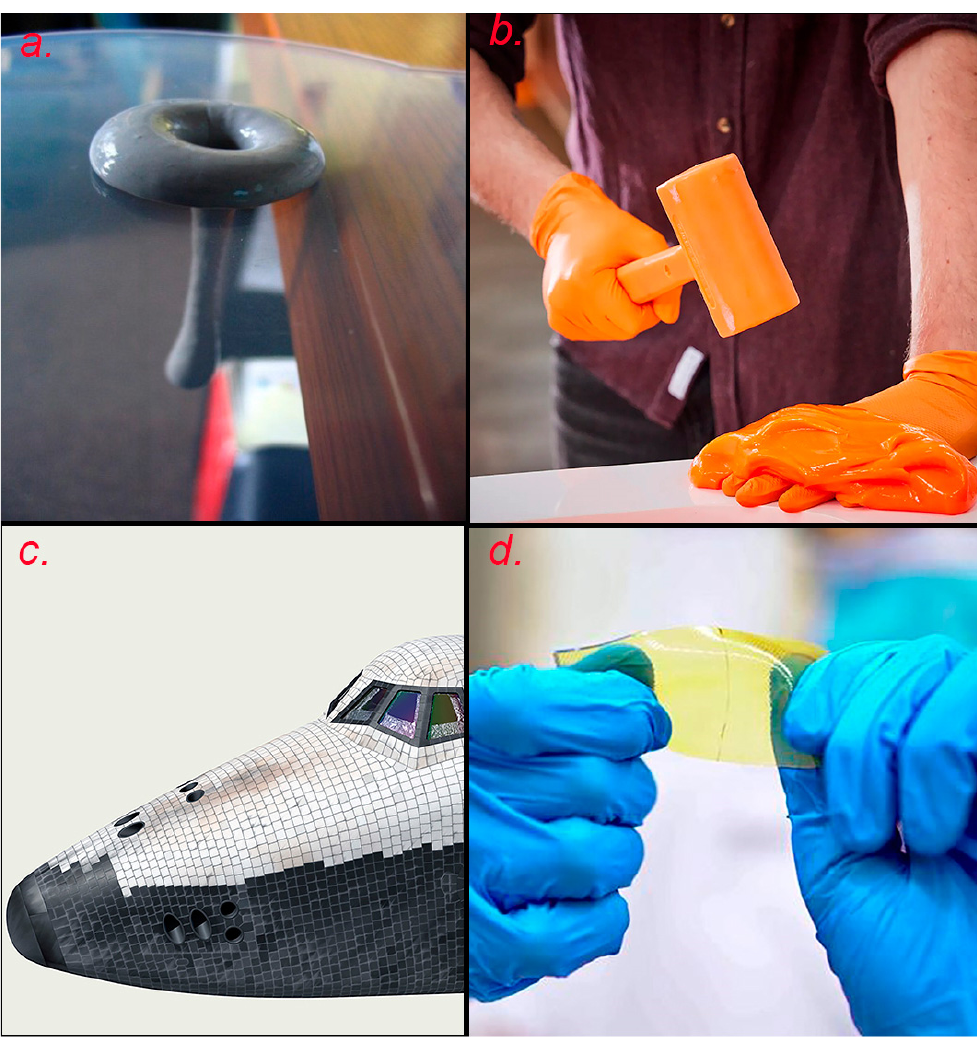
Figure 1. Representation of the use of PBS as rheological liquids ( a ) for the manufacture of protection against mechanical damage ( b ), as fire ‐ resistant ceramics ( c ) and in self ‐ healing materials ( d ).